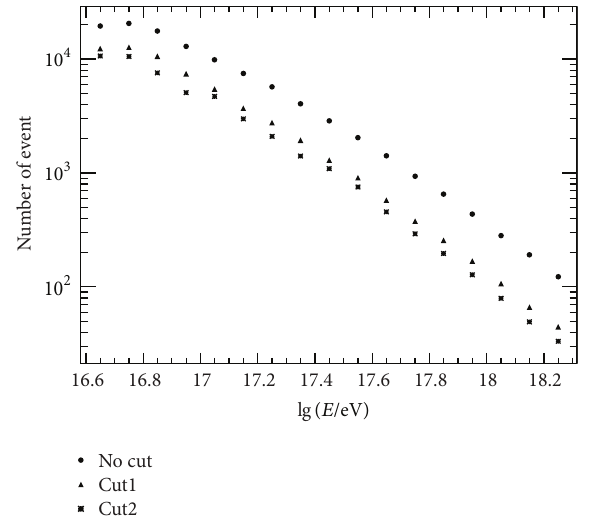
Figure 8: Event rate per year in three conditions, respectively.